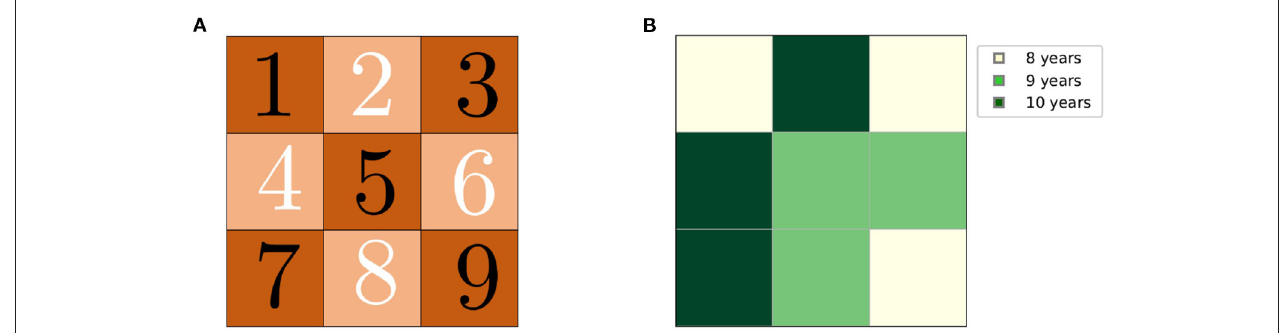
(as compared to the random initial policy) in less than 1,000 episodes. DRL rewards exceed GA rewards in 1.68 times faster computational